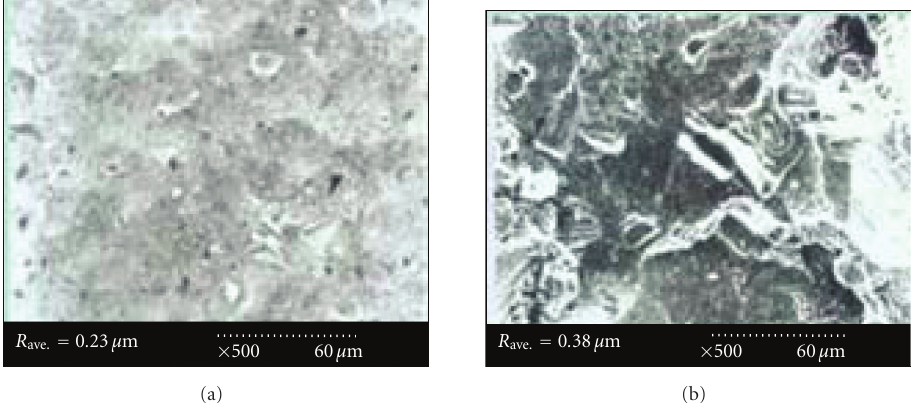
Figure 5: SEM surface images and surface roughness of shower head with over 1000 silicon nitride deposition counts on di ff erent substrates (a) silicon oxide substrate and (b) Cu substrate with NH 3 plasma